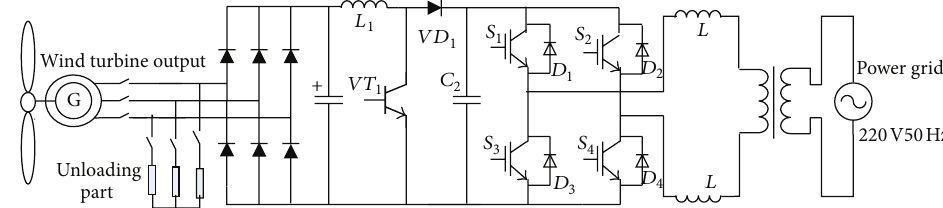
Figure 1: The topology structure of the small wind power generation